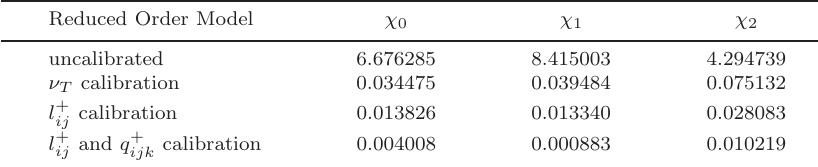
Table 2. Three-equation ROM prediction errors.